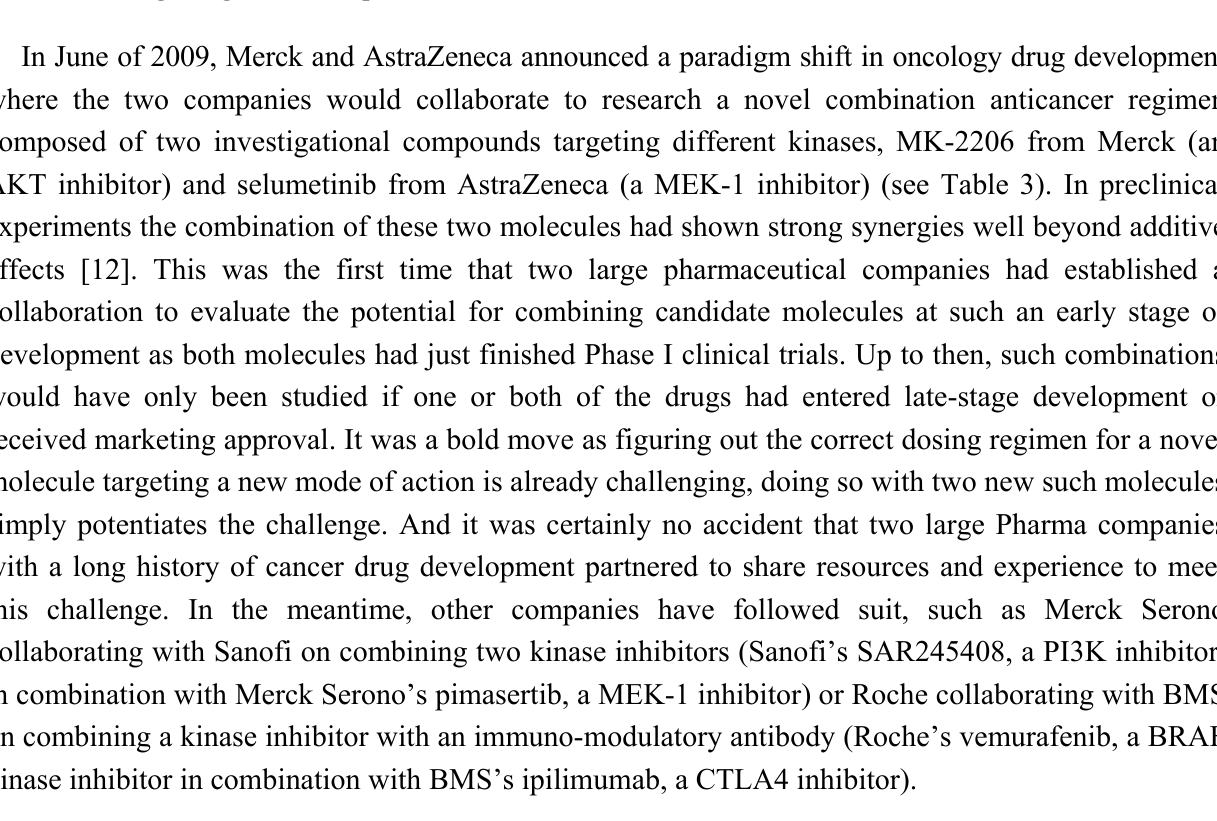
Table 3. Some examples of Pharma–Pharma collaborations in